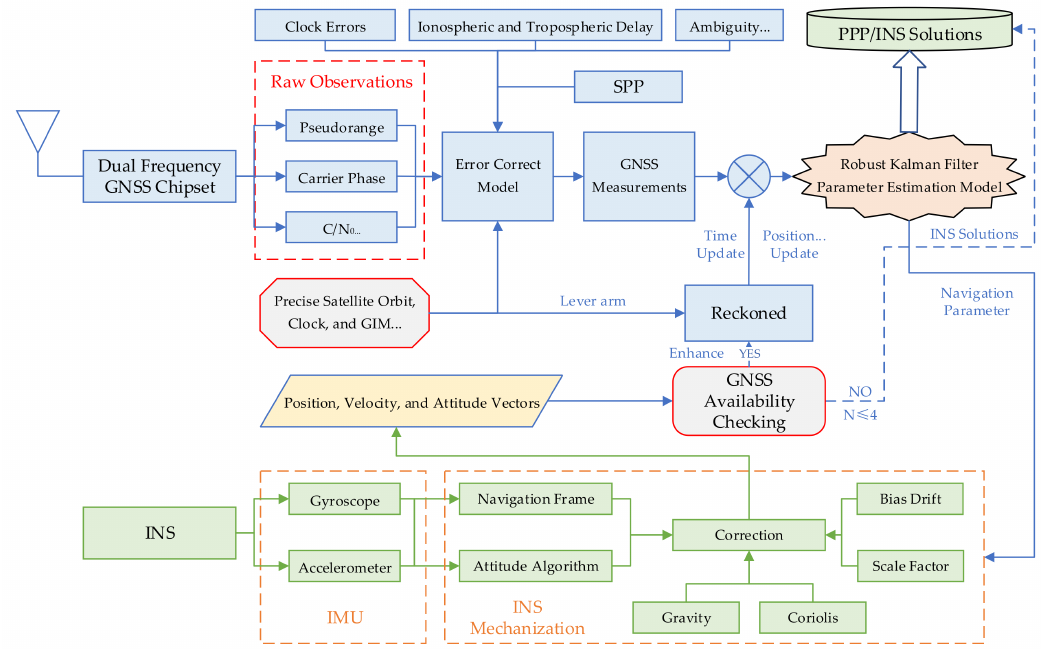
Figure 10. The flow chart of GNSS PPP/INS integrated navigation on